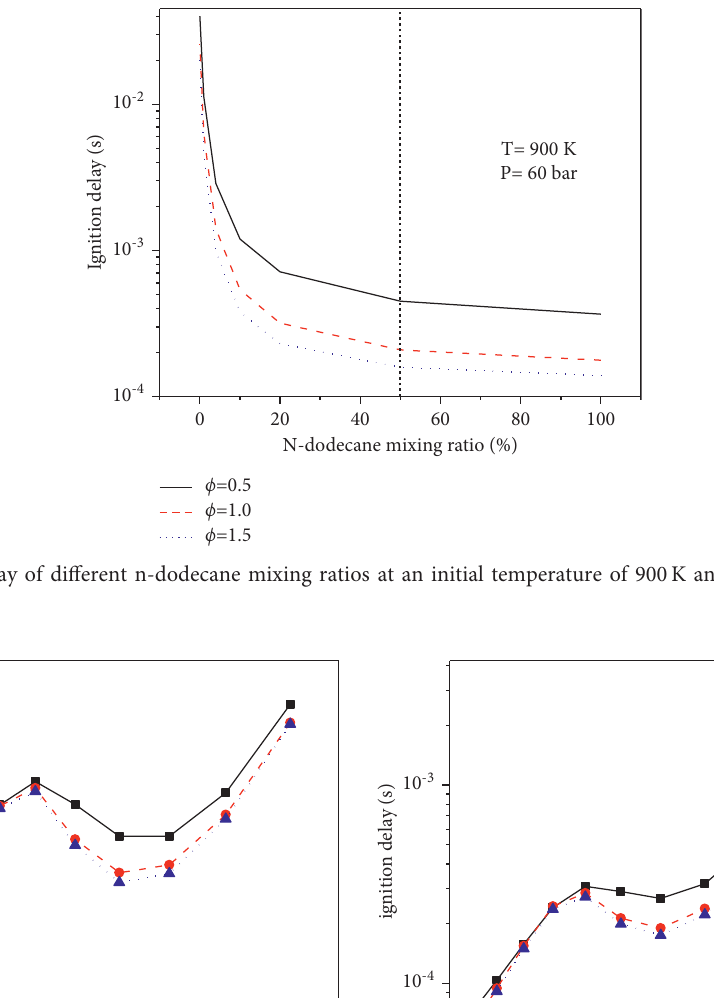
Figure 8: Different effects of methane addition on ignition delay